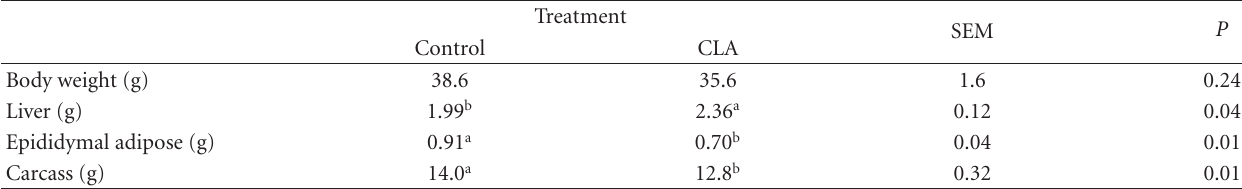
Table 2: Live body weight and weights of selected tissues and carcass in mice fed trans -10, cis -12-CLA (CLA).